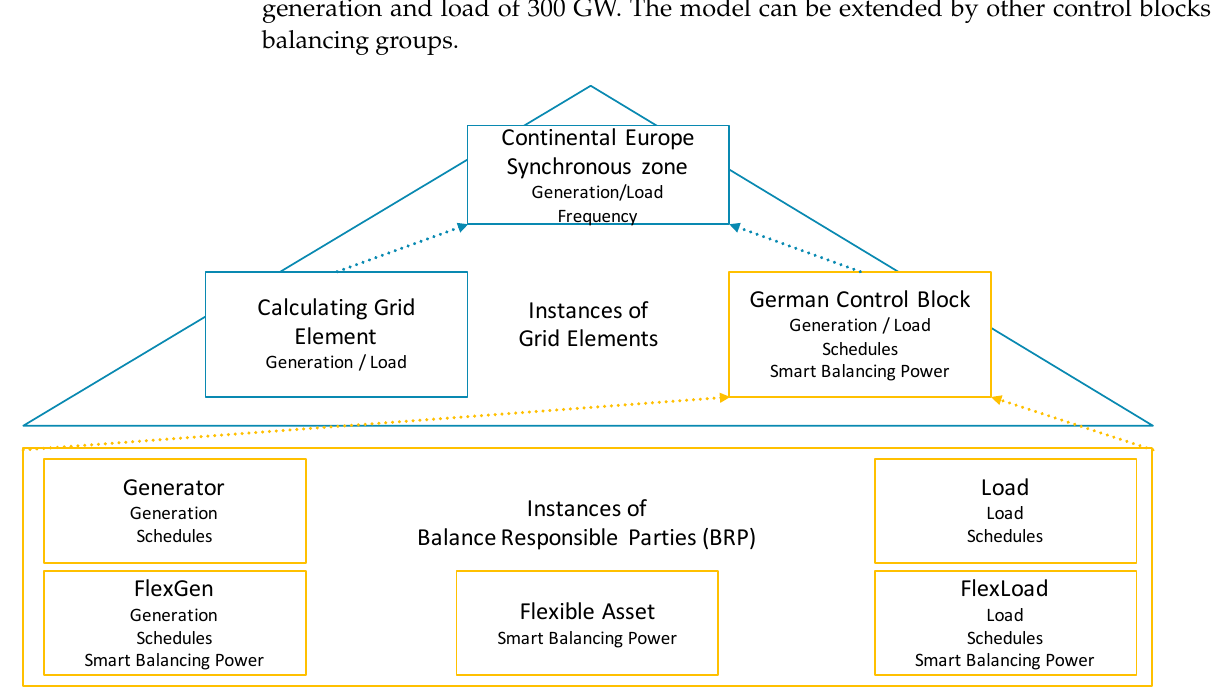
Figure 1. Smart balancing model: structure of objects and most important